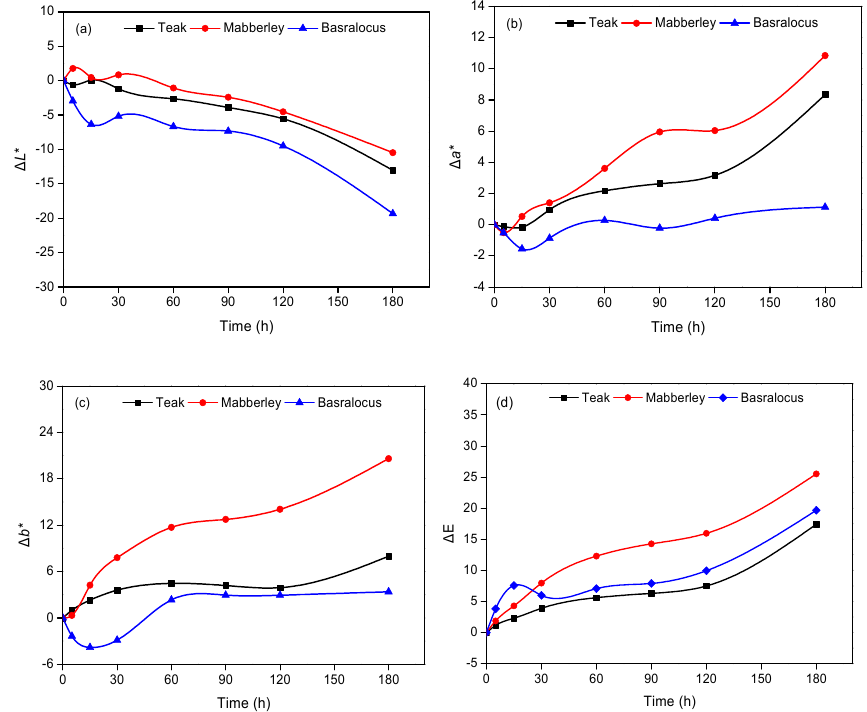
Figure 3. Color changes of woods during artificial xenon light weathering. ( a ) ∆ L *; ( b ) ∆ a *; ( c ) ∆ b *; ( d ) ∆ E